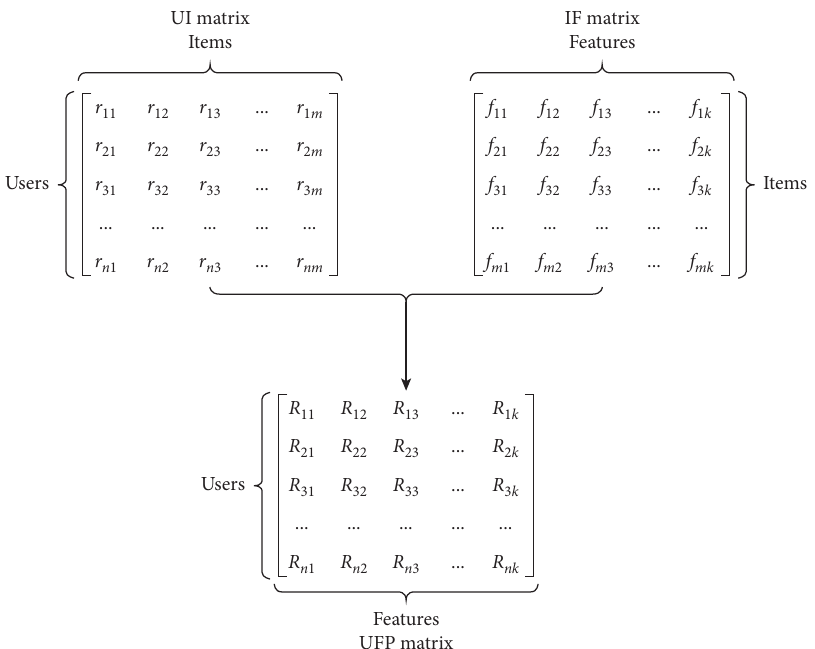
Figure 4: Basic flow of user preference feature matrix construction